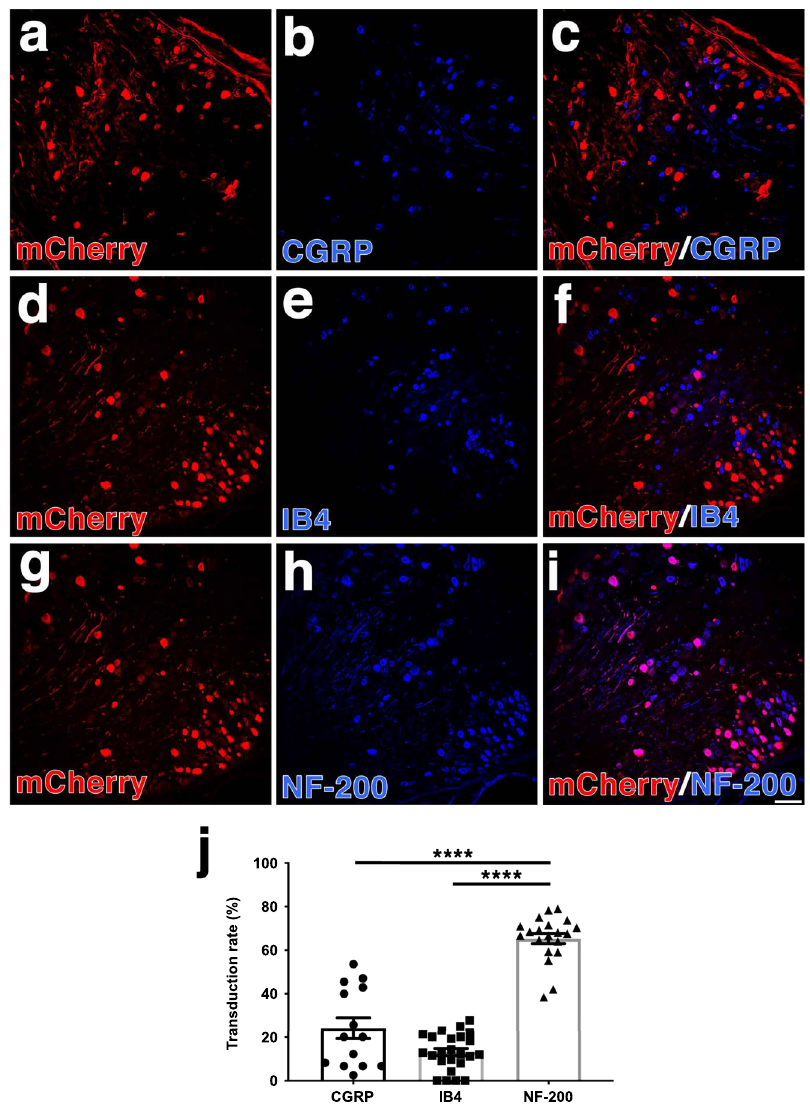
Fig. 2 Intraganglionic injections of AAV5-hSyn-hM3Dq primarily transduces large caliber DRGs. a – i AAV5-hSyn-hM3Dq was injected into the right C5- C8 DRGs. Four weeks later, the DRGs were isolated and immunostained for mCherry ( a , d , g , red) and calcitonin gene related peptide (CGRP; b , blue), IB4 ( e , blue) or NF-200 ( h , blue). We observed mCherry expression mostly in large diameter, NF-200 + neurons ( g – i ) rather than nociceptive CGRP + ( a – c ) or IB4 + neurons ( d – f ). j Quanti fi cation of the transduction rates in CGRP + , IB4 + and NF-200 + neurons demonstrates that AAV5 transduces NF-200 + neurons more ef fi ciently than smaller caliber, nociceptive neurons. N = 12 animals. Mean ± SEM. One-way ANOVA and post-hoc multiple comparisons testing using the two-stage step-up method of Benjamini, Krieger, and Yekutieli, **** p < 0.0001. Scale bar: 100 µ m. Source data are provided as a Source Data fi